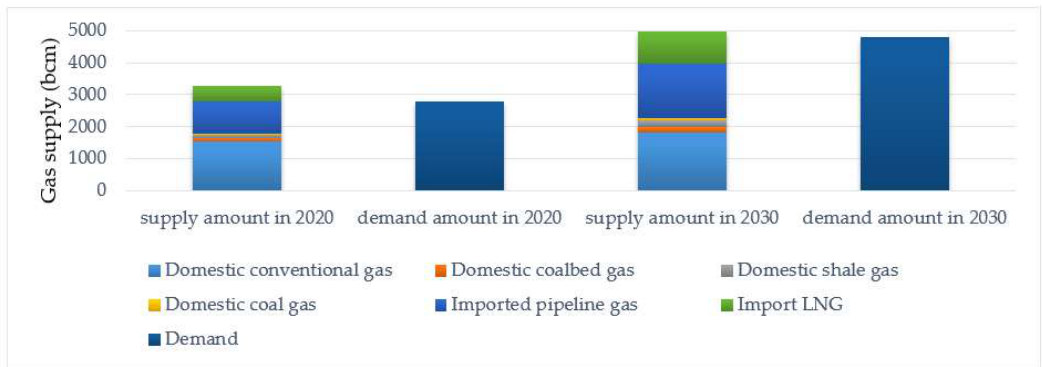
Figure 11. China’s natural gas supply and demand by 2020 and 2030.